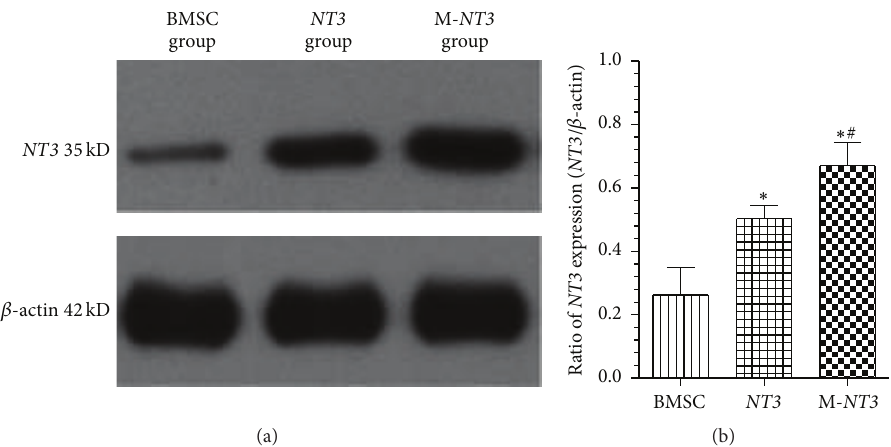
Figure 7: Western blot detection of NT3 protein expression in the injured spinal cords on day 35 after cell transplantation in each group (a). Ratio of the lane density of the NT3 protein to the lane density of the 𝛽 -actin protein in each group (b). The data, which are presented as the means ± SD ( 𝑛 = 12 ), were analyzed using one-way ANOVA. ∗ 𝑝 < 0.05 versus the BMSC group, # 𝑝 < 0.05 versus the NT3